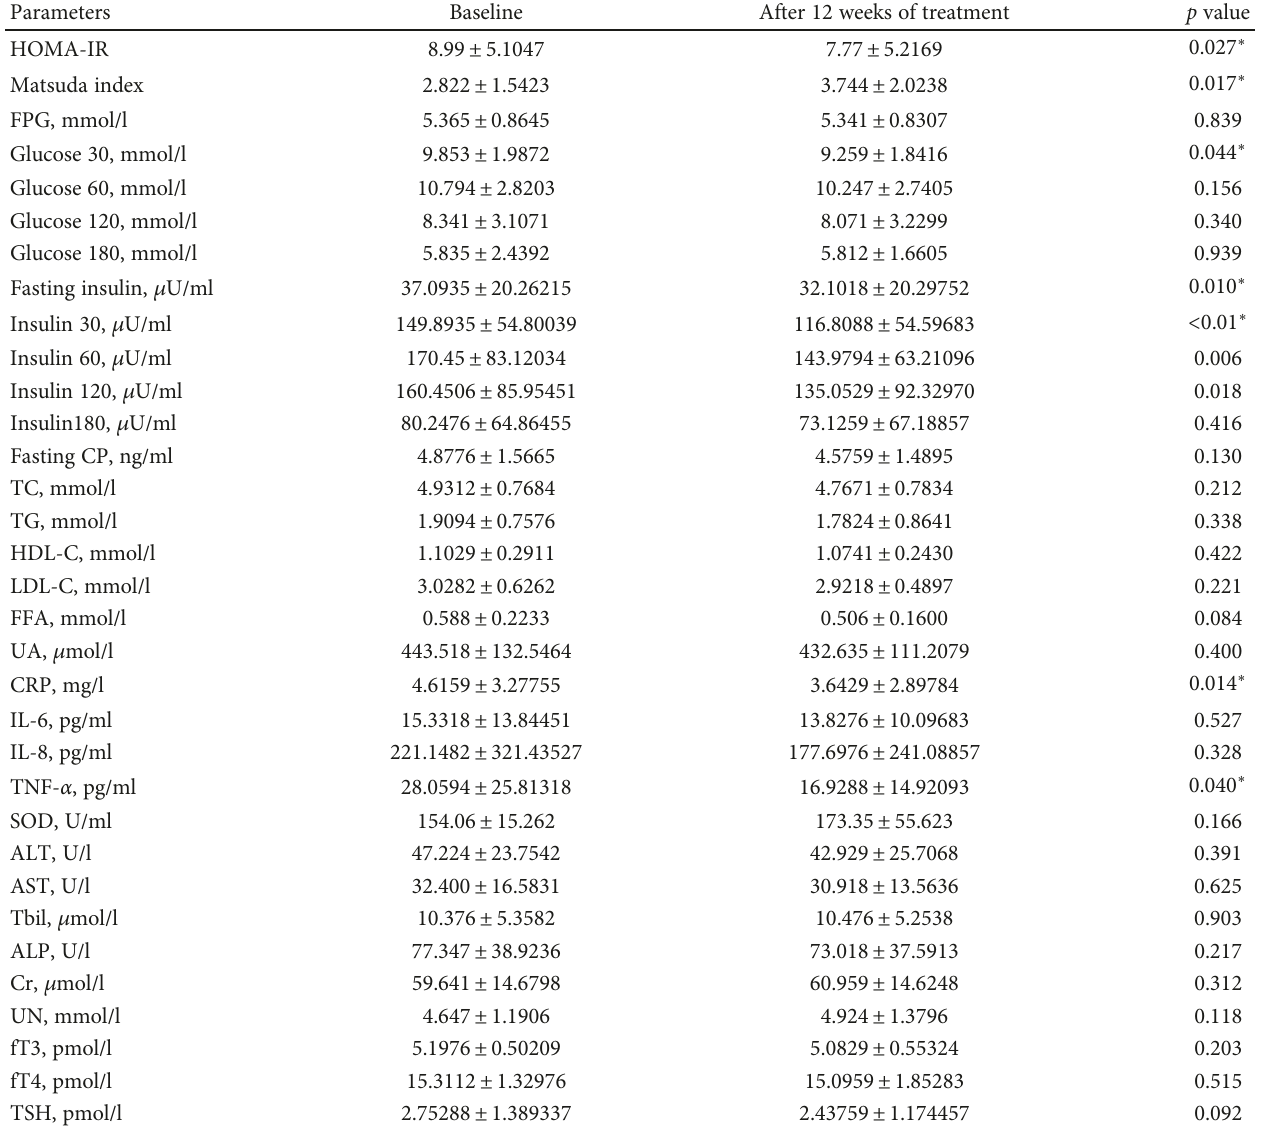
Table 1: E ff ects of melatonin on various biochemical